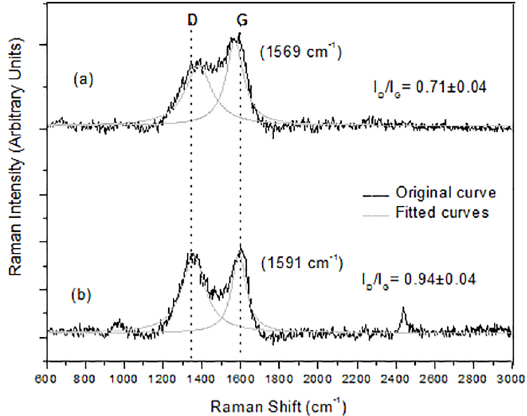
Figure 5. Raman spectra of Ni-1: (a) before the heat treatment and (b) after the heat treatment at slow heating rate